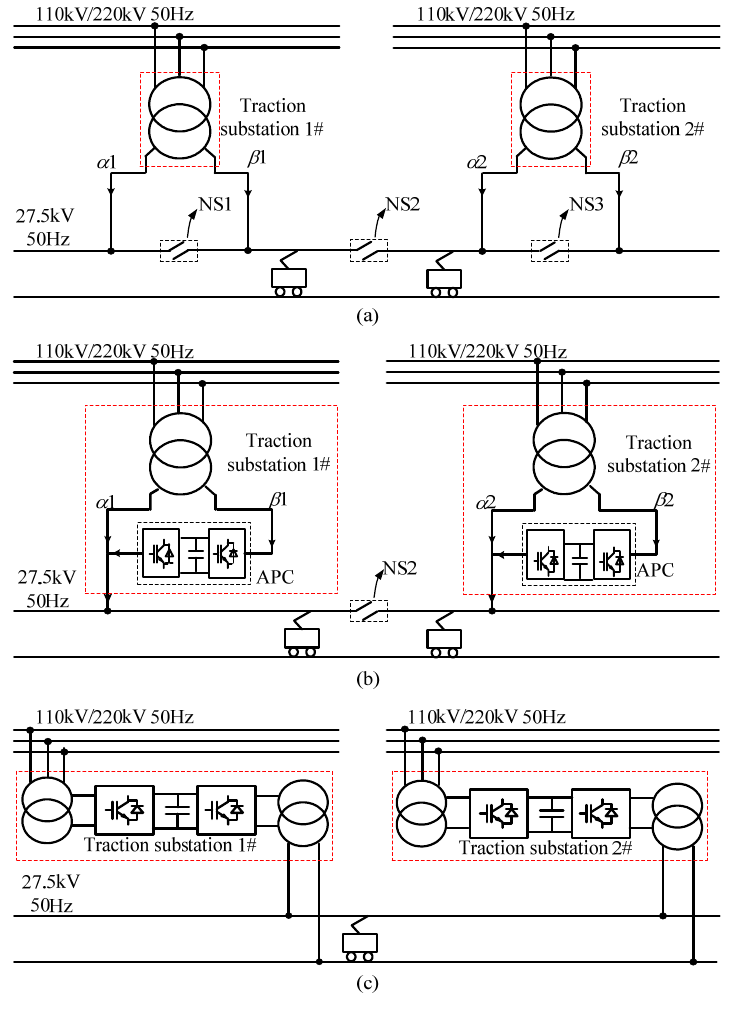
Figure 1. Traction power supply system modes: ( a ) The existing traction power supply system; ( b ) The co-phase traction power supply system; ( c ) The advanced traction power supply